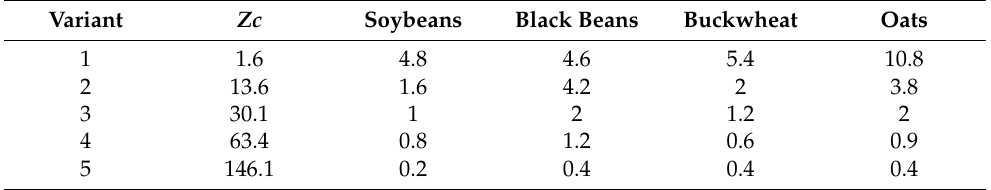
Table 7. The biological absorption coefficients of copper for all crops and the total pollution